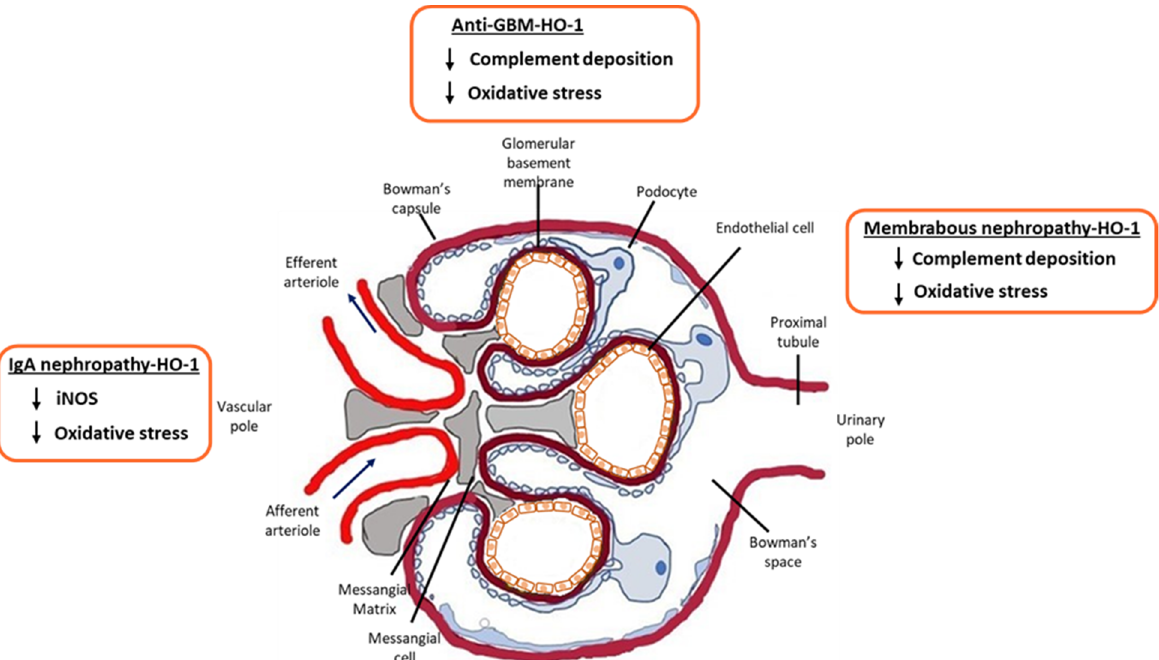
Figure 2. HO-1 immunomodulatory effects in glomerular diseases. Schematic representation of the effect of HO-1 in diseases that affect the glomerulus.